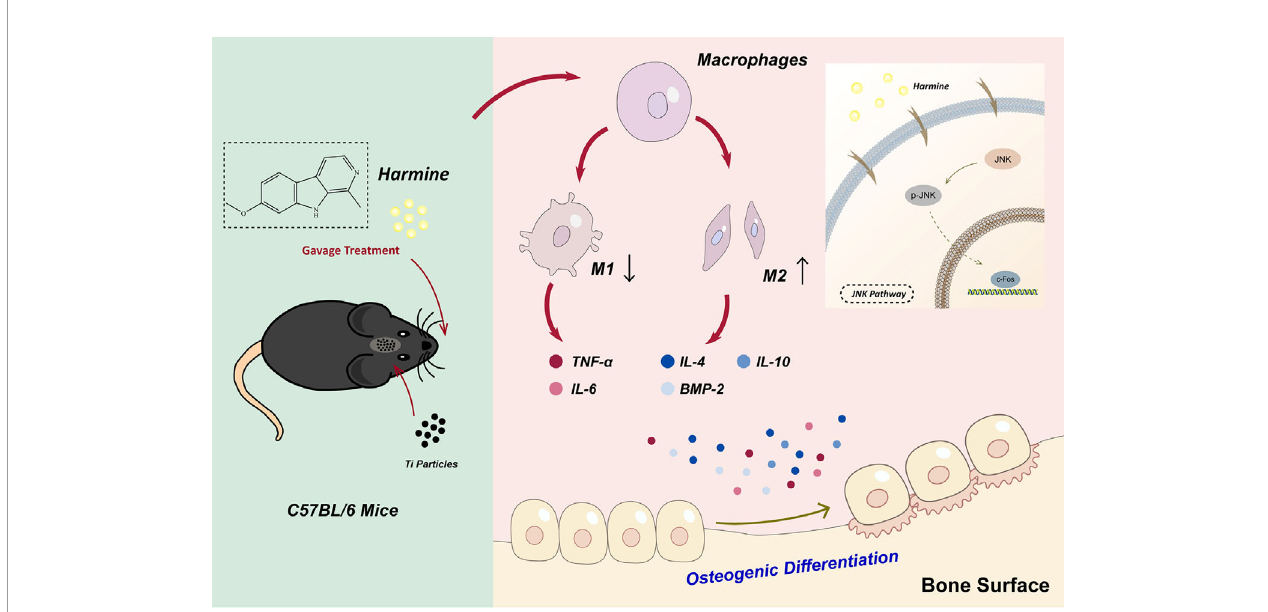
FIGURE 8 | Harmine alleviated the particle-induced in fl ammation and facilitated the polarization of macrophages from M1 phenotypes to M2 phenotypes by blocking the JNK signaling pathway as well as osteogenic formation in vitro and in vivo